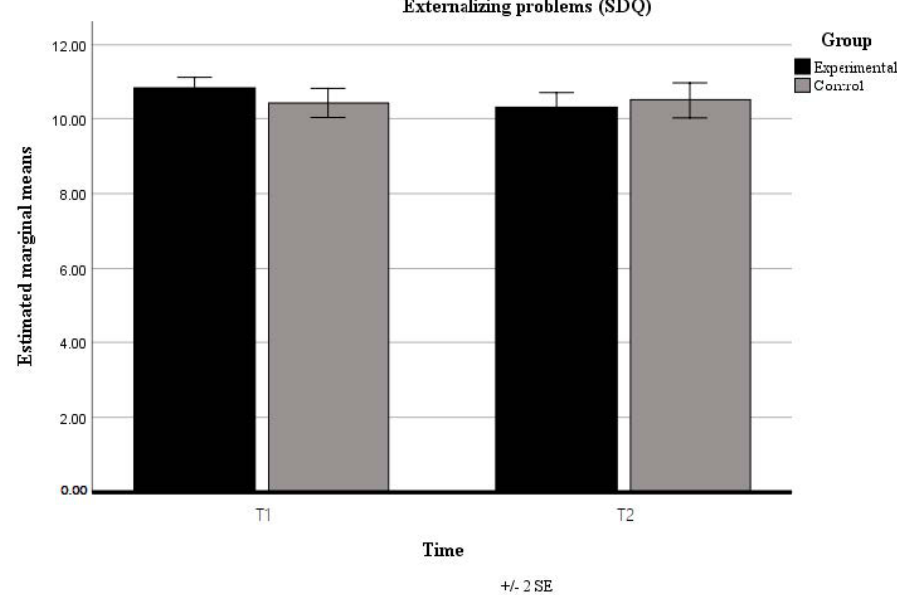
Figure 1. Interaction between time and group in externalizing problems